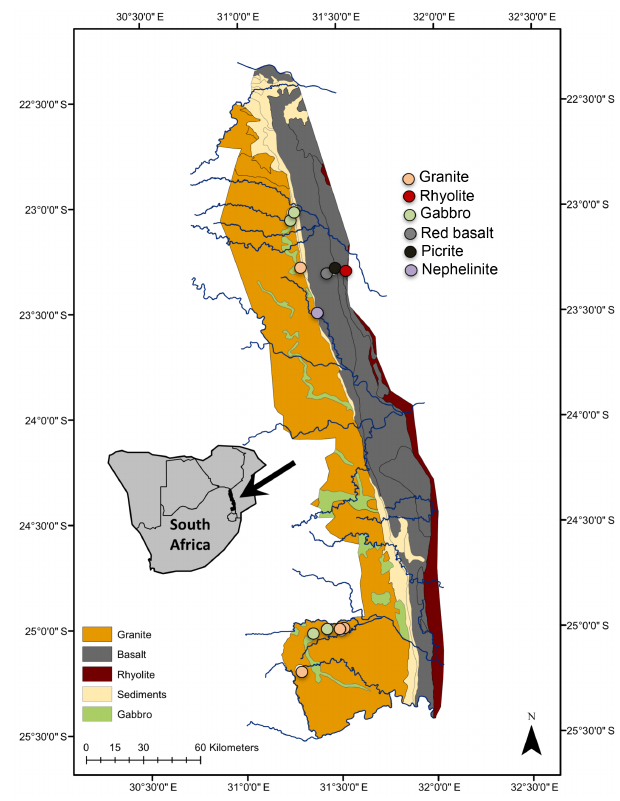
Figure 1. Locations and lithology of parent materials where soils were sampled for this study. Rainfall decreases from ∼ 740mma − 1 in the southern end of the park to ∼ 450mma − 1 in the northern end of the